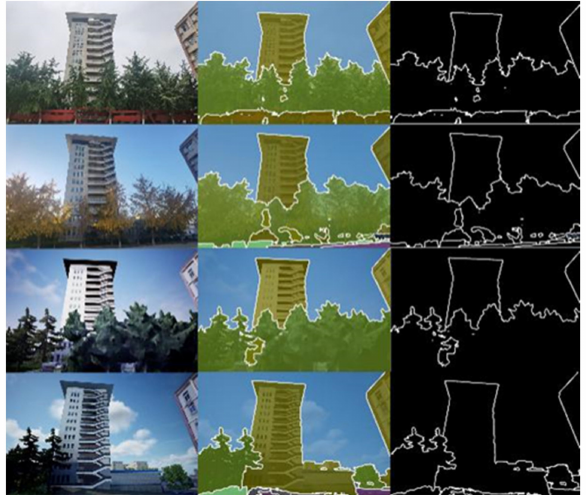
Figure 1. An example of a scene and the 3D model changing over the time. The second column represents the semantic segmentation. Except for the vegetation, the section with the same semantic information is observed to show less variation. The third column represents the segmentation edge. It is observed that the edge of the ground object (except the vegetation) is very similar. This indicates that the confidence rate of the feature points on the edge is high when used as a matching